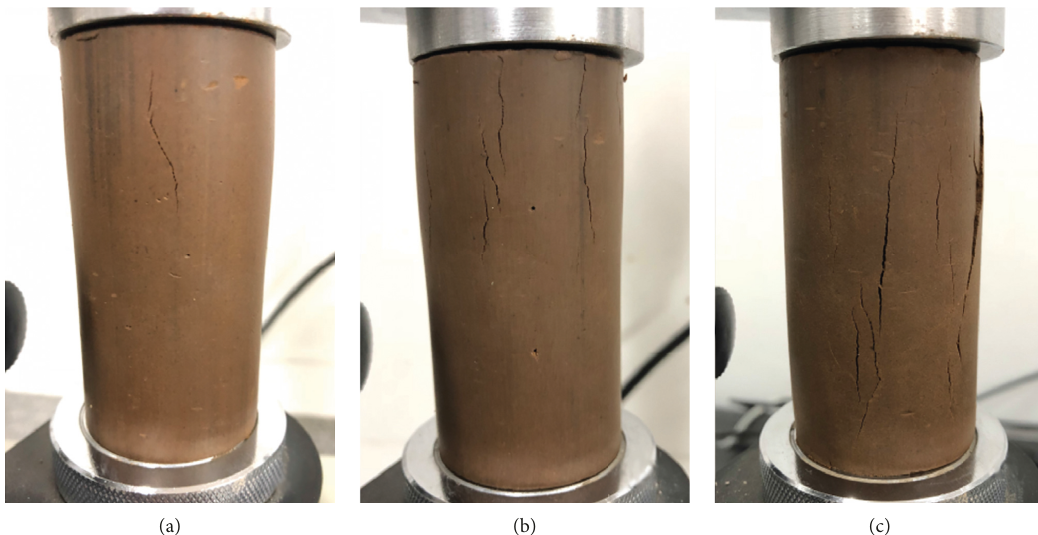
Figure 10: Photos of specimens after failure undergoing five wetting-drying cycles: (a) cyclic amplitude EMC